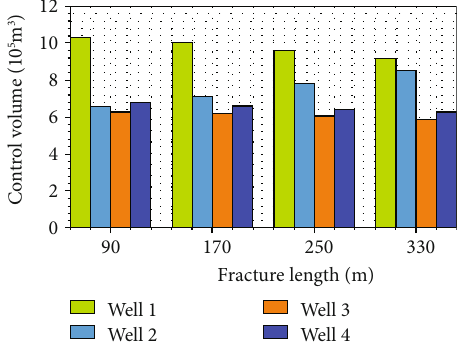
Figure 14: Control volumes of the production wells with di ff erent fracture lengths of well